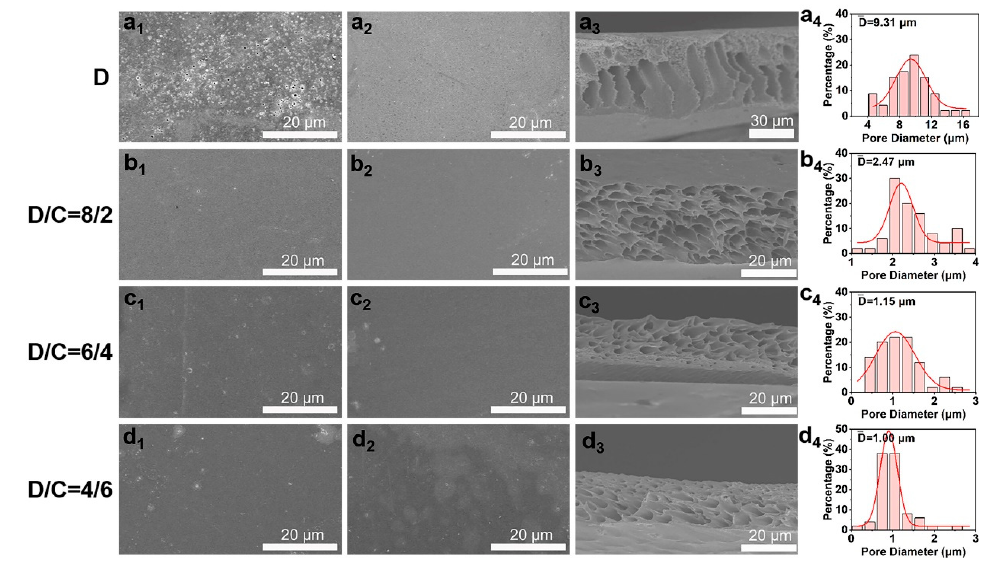
Figure 3. Typical SEM images of top surfaces ( a 1 – d 1 ), bottom surfaces ( a 2 – d 2 ), and cross-sections ( a 3 – d 3 ) of porous sPI films using mixed DMF/CHCl 3 (D/C) solvents with various weight ratios. Panels ( a 4 – d 4 ) displaying pore size distributions in the porous sPI films. Table 2. Hansen solubility parameters of all components in phase separation to fabricate porous films.